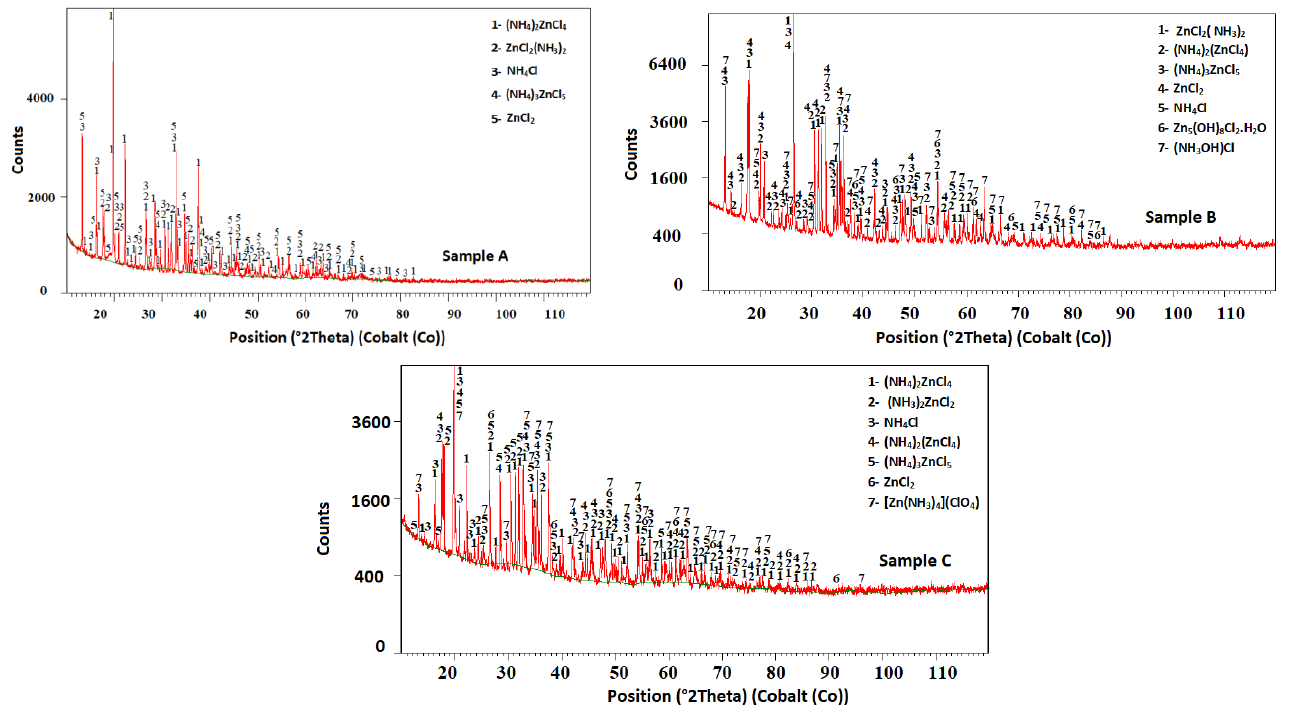
Figure 1. X-ray diffraction (XRD) patterns of Zn samples A, B and C.